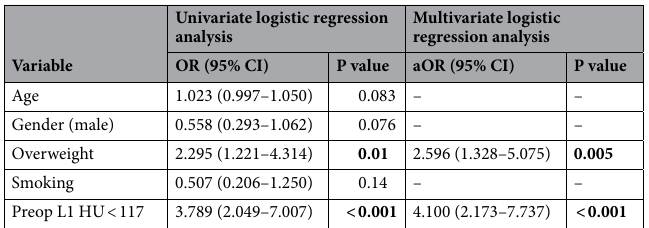
Table 3. Univariate logistic regression analyses and multivariate logistic regression analyses. HU hounsfield units, OR odds ratio, CI confidence interval. Significant values are in bold.